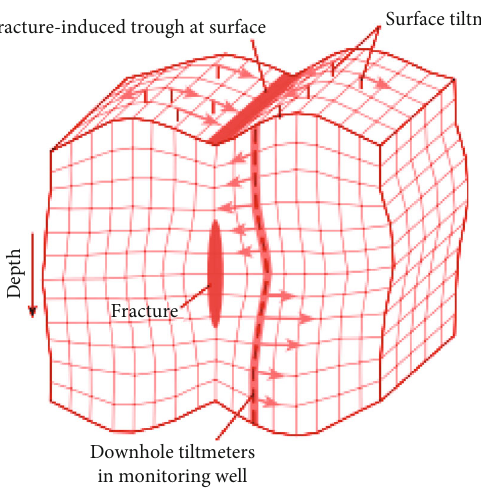
Figure 5: Schematic of tilt fi elds generated from deformation during fracturing modi fi ed after [72].